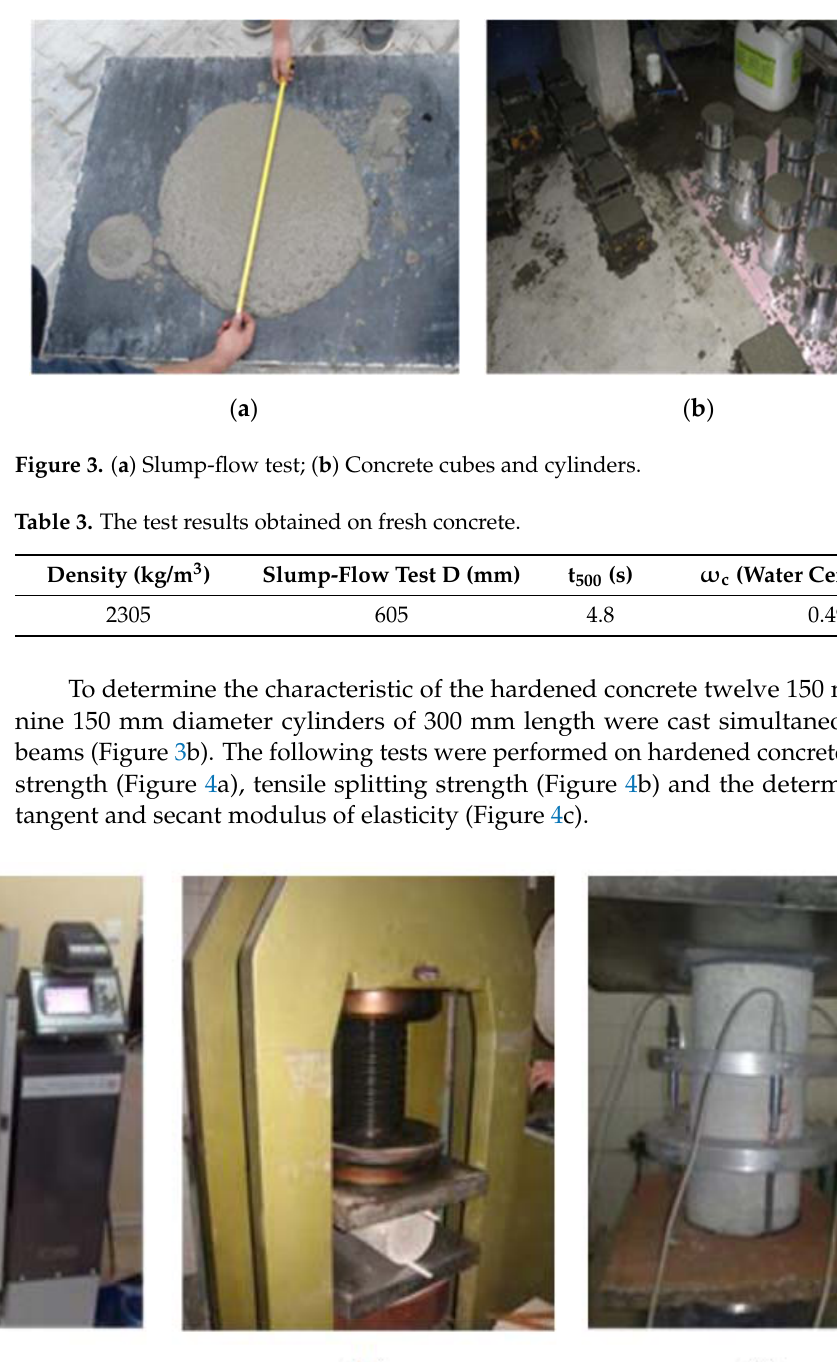
Figure 4. Determination of the characteristics of hardened concrete: ( a ) Compressive strength; ( b ) Tensile strength; ( c ) Modulus of elasticity.